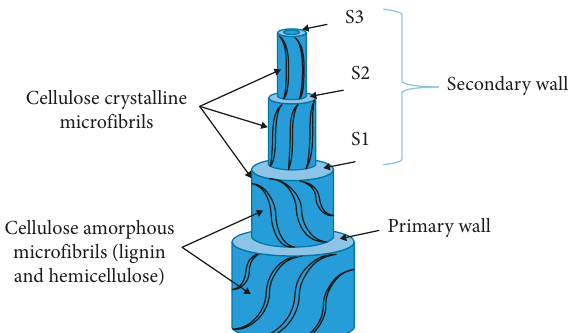
Figure 1: Fibre classification.